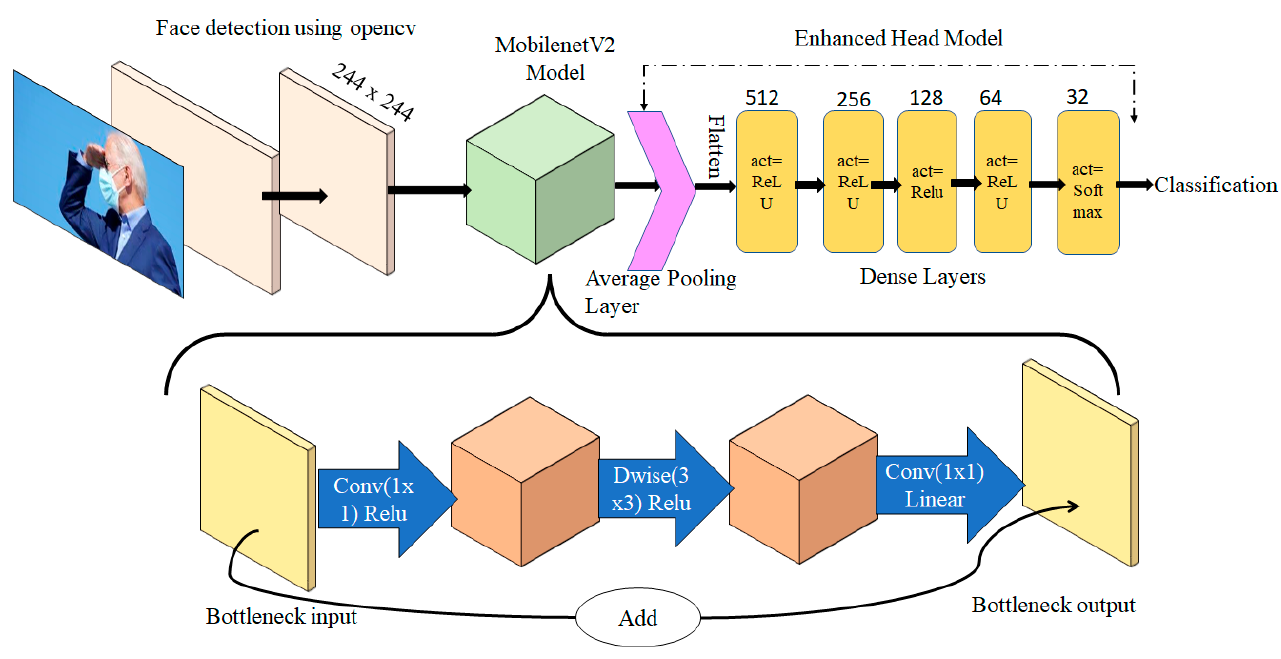
Figure 4. Face mask detection.